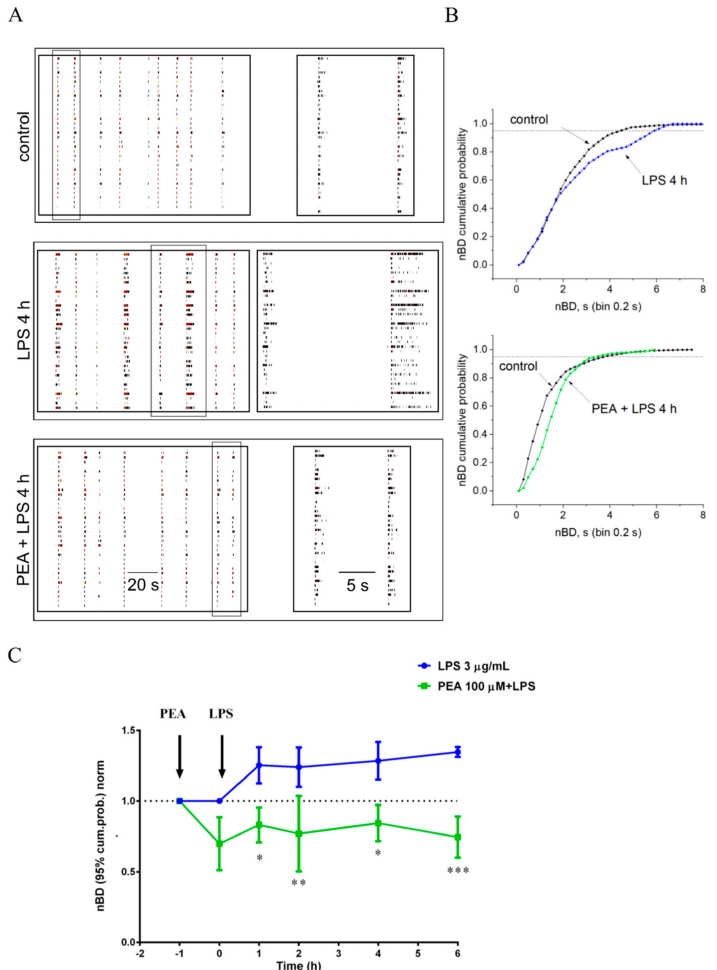
Figure 9. Protective effect of PEA on LPS-induced inflammation and hyperexcitability of cortical network. ( A ) Representative example of raster plot of patterns of spontaneous burst activity in control condition after 4 h of 3 µ g/mL LPS administration and during 100 µ M PEA + LPS. PEA was administered 1 h before LPS. In each condition, a couple of bursts were boxed and shown in a new window with a time scale enlarged, on the right of panel A. Each vertical line is a timestamp representing a single spike, and the global network burst duration (BD) is computed considering all neurons (distributed on the row). ( B ) Plots of superimposed BD cumulative probability histograms in control (black line), after 4 h of LPS administration (upper panel) and LPS with PEA pre-administered (lower panel). The data are obtained, computing all the BDs in temporal windows of 30 min, then, the cumulative probabilities of the time lapse of interest were normalized to the maximum value. Number of analyzed bursts in represented experimental steps were 110 in control, 103 in LPS, and 108 in PEA + LPS. On cumulative distribution, the statistical significance, obtained by Kruskal–Wallis non parametric test, was p < 0.01 for LPS vs control and p > 0.05 for PEA + LPS vs control. The value of cumulative distribution of the burst durations (cumBD) at 95% of probability (dot line) in the upper panel changed from 4.4 s, in control, to 6 s, in LPS; in the lower panel the same value is 3.6 s in control and 3.55 s in PEA + LPS condition. ( C ) Time plot of cumBD data at 95% of probabilities; each point in the indicated time lapse represents averaged data normalized at the control (dot line). Significant differences for PEA + LPS (green line) vs LPS (blue line) were determined at all experimental steps by Holm–Sidak method. 0.832 ± 0.123 and 1.253 ± 0.128, 0.769 ± 0.267 and 1.240 ± 0.139, 0.844 ± 0.127 and 1.285 ± 0.132, 0.745 ± 0.146 and 1.347 ± 0.034 were, respectively, the values for PEA + LPS and LPS at 1, 2, 4, and 6 h ( n = 3 independent experiments for each condition). No significant effect was observed in PEA versus control. Data are expressed as mean ± S.E.M. * p < 0.05, ** p < 0.01, *** p <